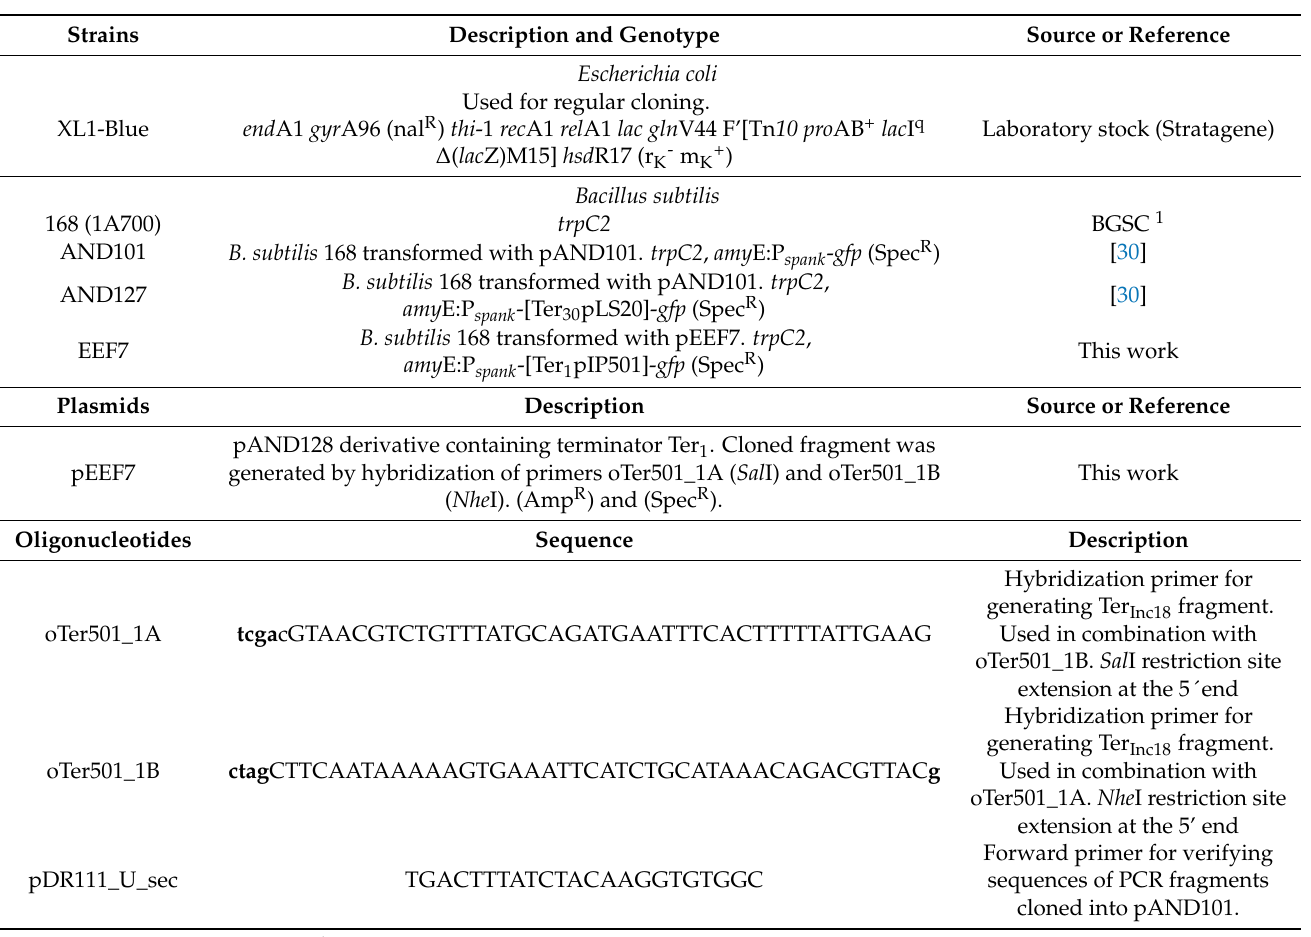
Table 1. Strains, plasmids and oligonucleotides